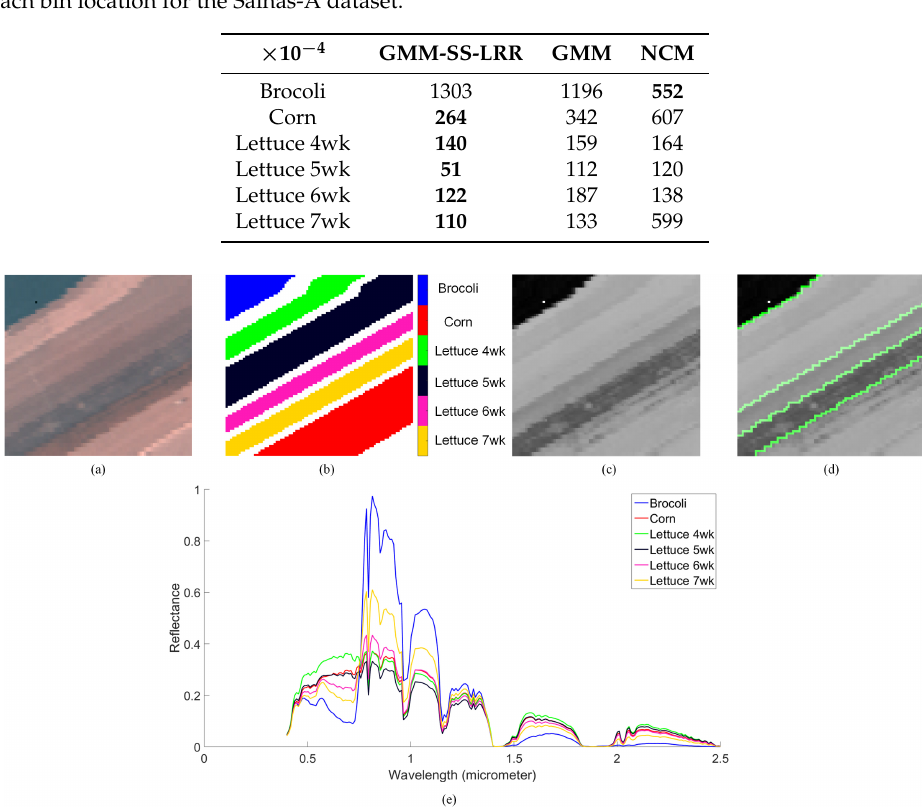
Table 6. The RMSE calculated between the probability value in each histogram and the estimated value at each bin location for the Sainas-A dataset.